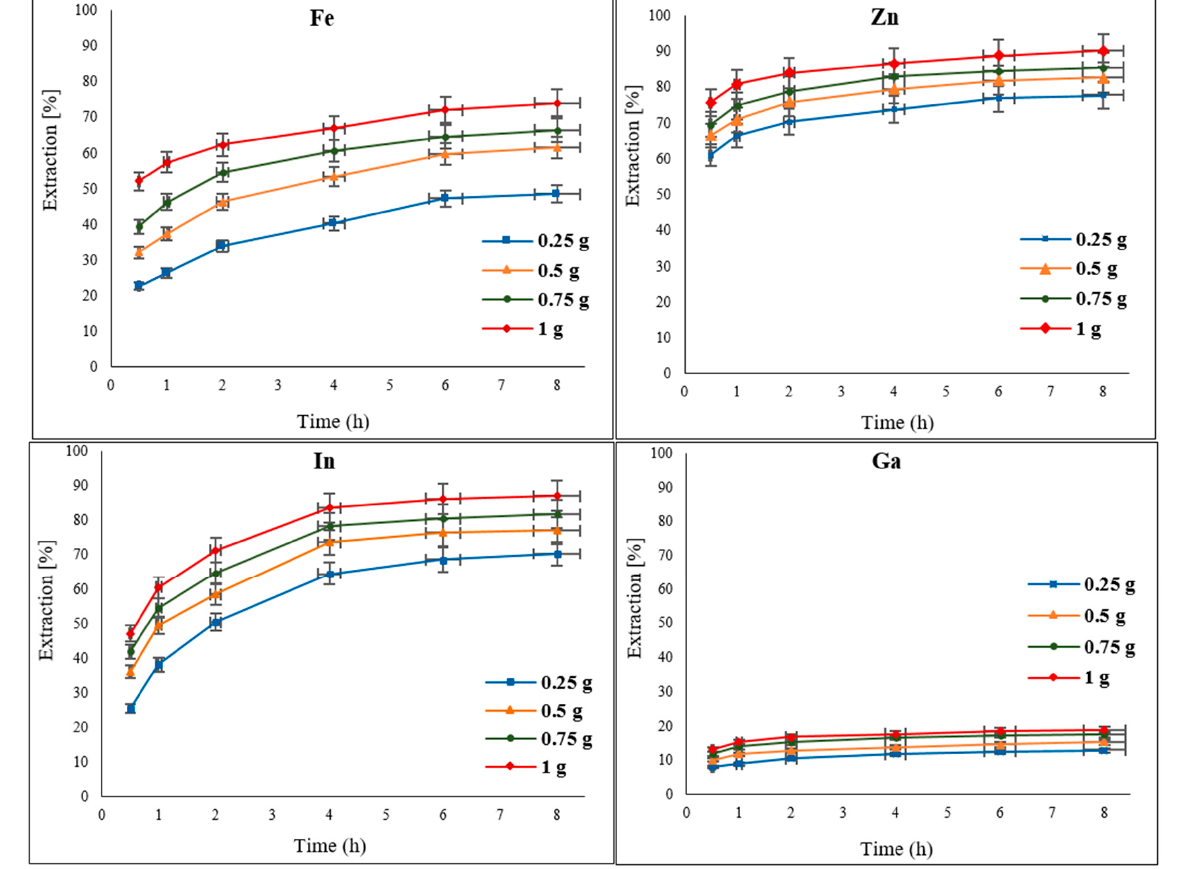
Figure 6. Effect of different concentrations of the oxidant Fe 2 (SO 4 ) 3 (0.25, 0.5, 0.75, and 1 g) on the extraction of Fe, Zn, In, and Ga from EAFD. Experimental conditions: 50 mL of 30% v / v [Bmim + HSO 4 − ], S/L ratio of 1/20, stirring speed of 500 rpm, temperature of 65 °C, and total leaching time of 8 h.